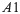
Graphs of PE, PF and PT for A1 of Example 1, where nT = nR = l = 2, and SNR is a function of Es.